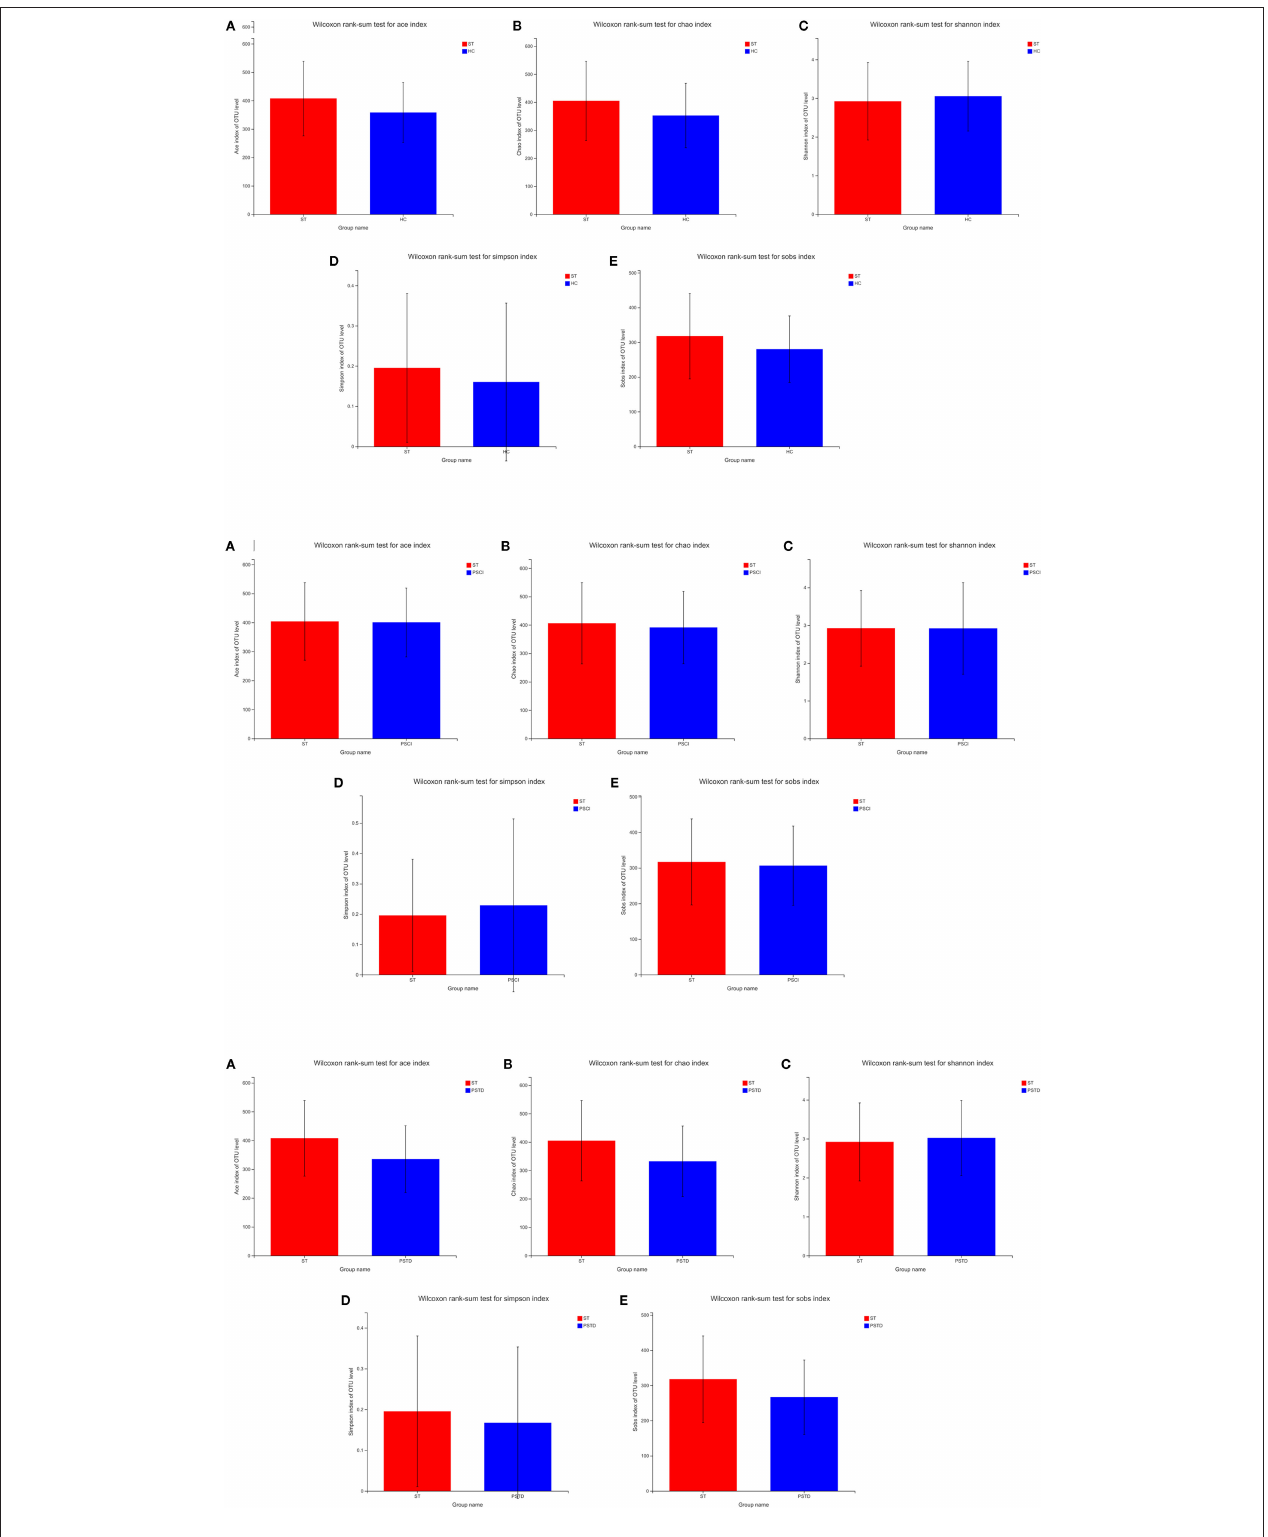
FIGURE 2 | (A) Alpha diversity indices in ST vs. HC. (B) Alpha diversity indices in PSCI vs. ST. (C) Alpha diversity indices in PSTD vs. ST.